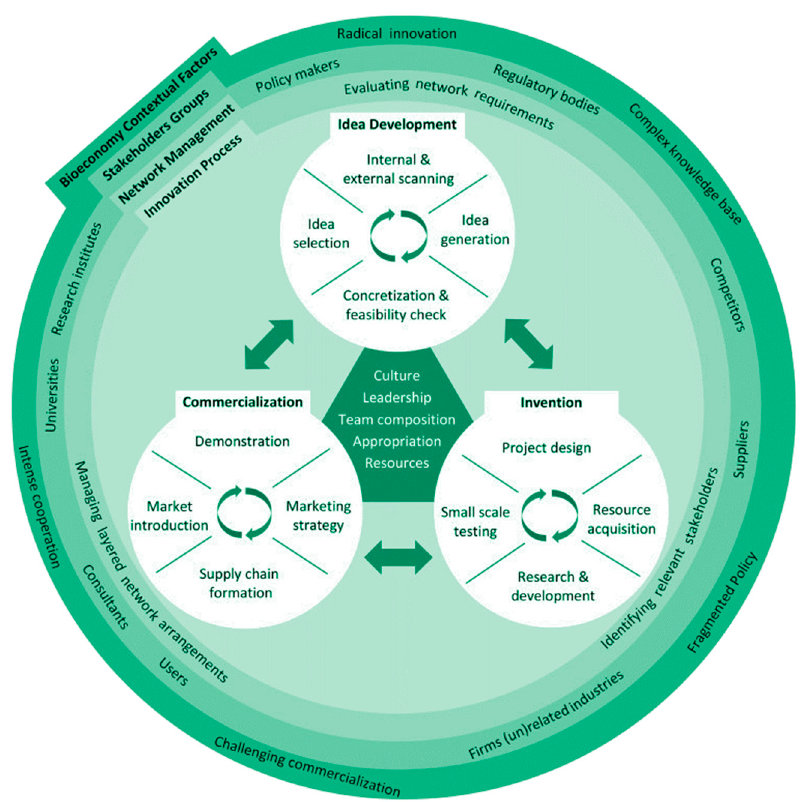
Figure 1. A schematic depiction of innovation in the bioeconomy framework (source: our elaboration with a reproduction with permission from [3], 2016).